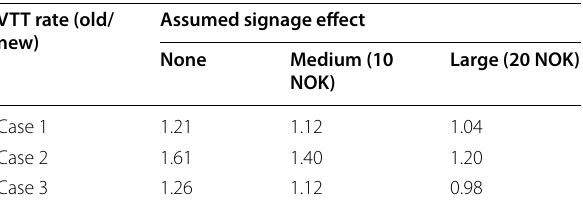
Table 4 Relative value of time given different assumptions of the signage